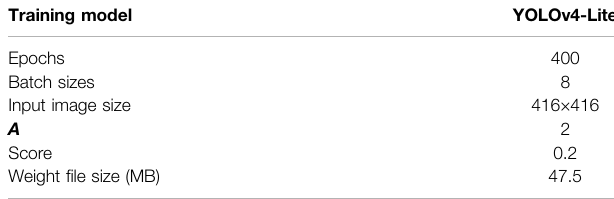
TABLE 3 | Training model